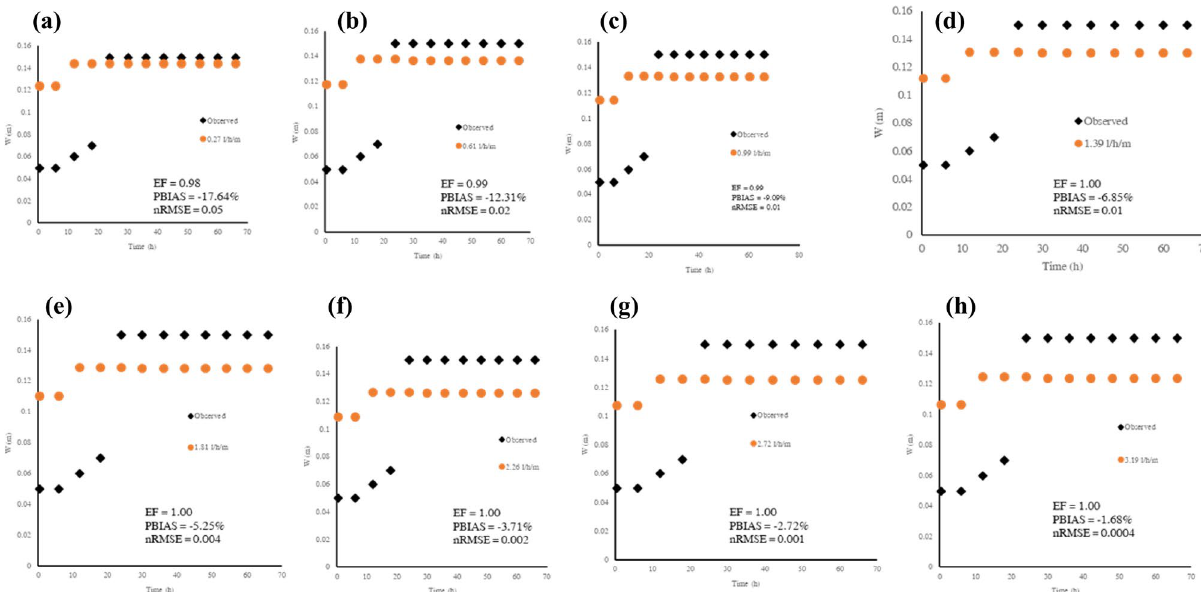
Figure 7. Observed vs Simulated wetted widths for silty clay loam at operating head of: ( a ) 20 kPa, ( b ) 40 kPa, ( c ) 60 kPa, ( d ) 80 kPa, ( e ) 100 kPa, ( f ) 120 kPa, ( g ) 140 kPa, and ( h ) 160